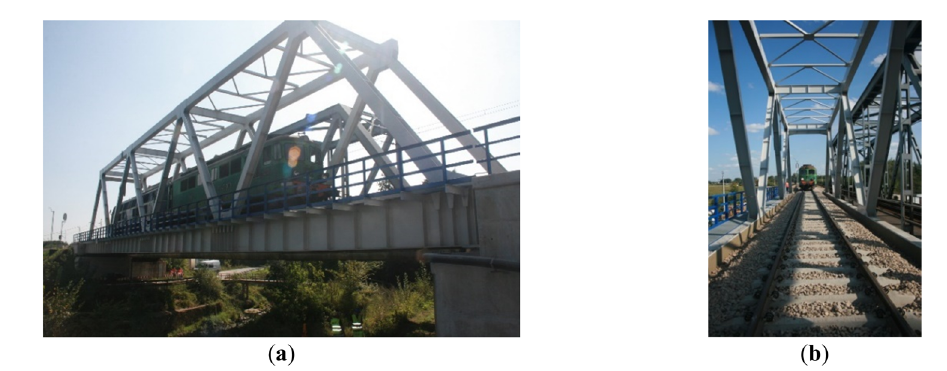
Figure 1: Bridge structure: ( a ) side view and ( b ) inside view. Source: The